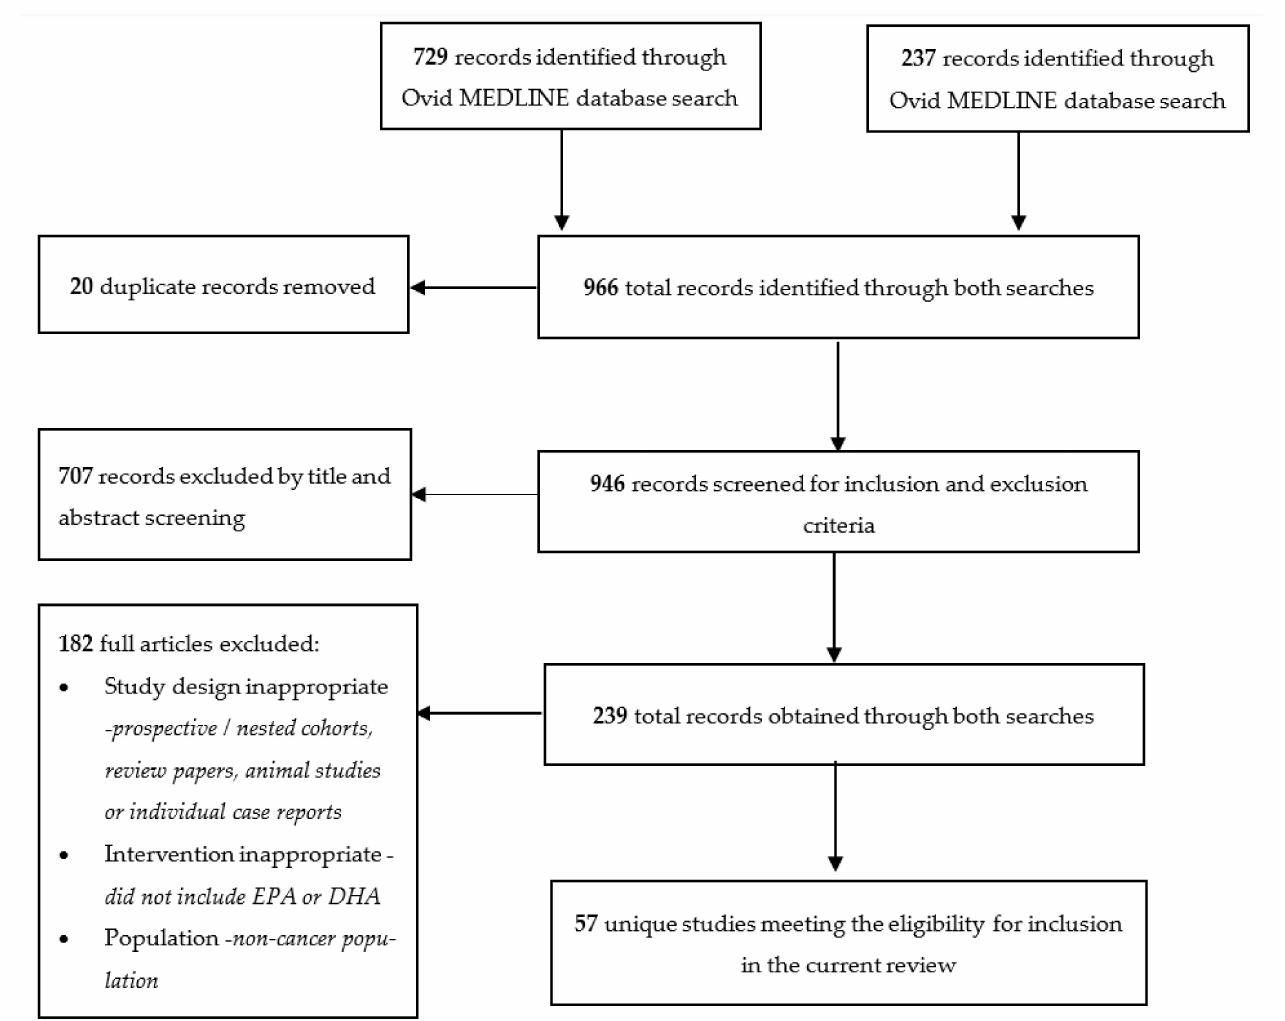
Figure 1. Flow chart of search and screening results for review